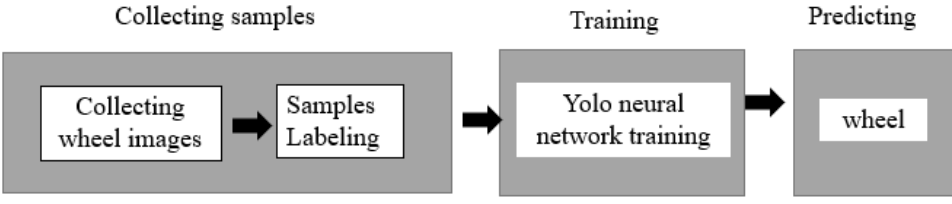
Figure 10. The training process of wheel image recognition system for autonomous vehicles.